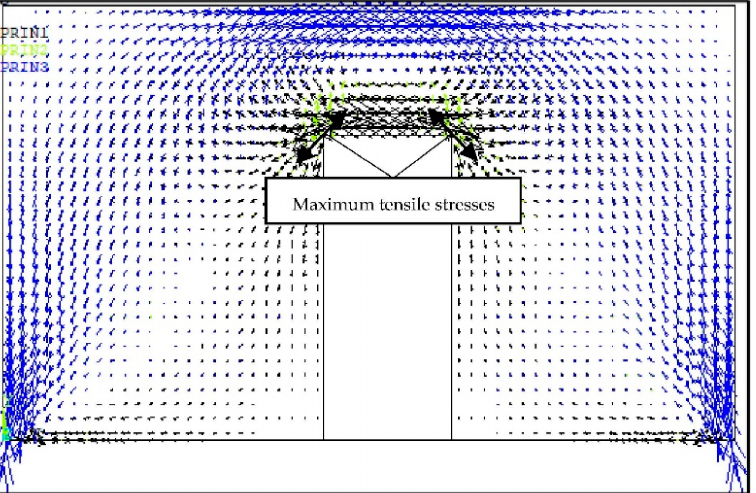
Figure 9. Trajectories of the main stresses in the non-load-bearing partition wall with door opening during deflection of the